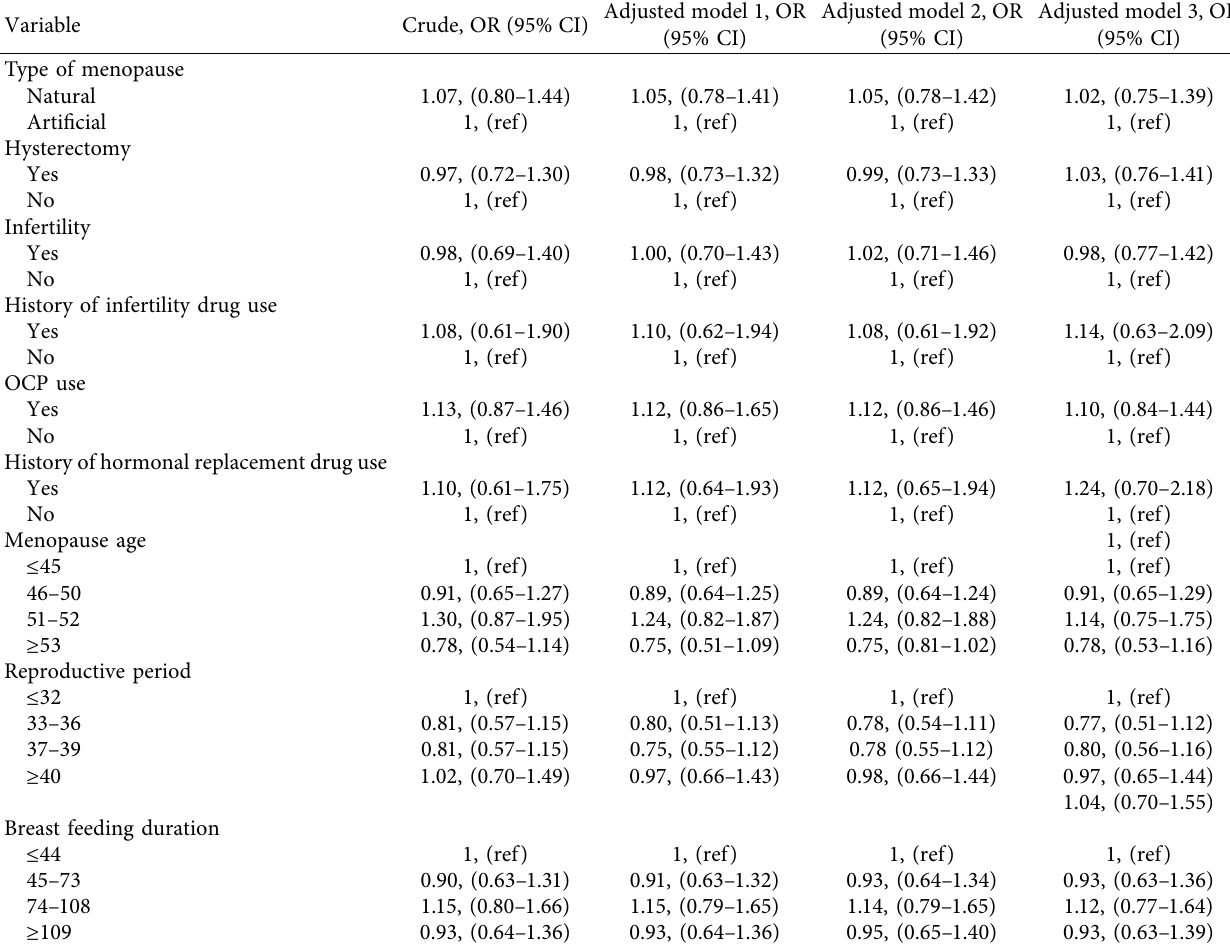
Table 2: Crude and adjusted ORs (95% CIs) for the prevalence of periodontitis (CAL ≥ 1mm) according to different lifetime hormonal fluctuation